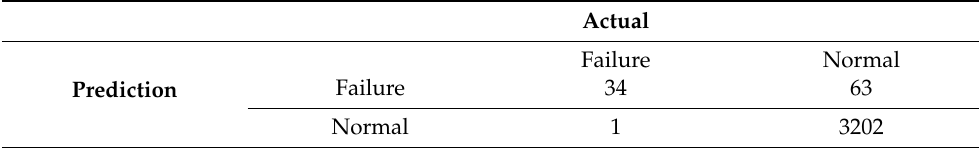
Table 9. Prediction results obtained for the HDF diagnosis using the confusion matrix.